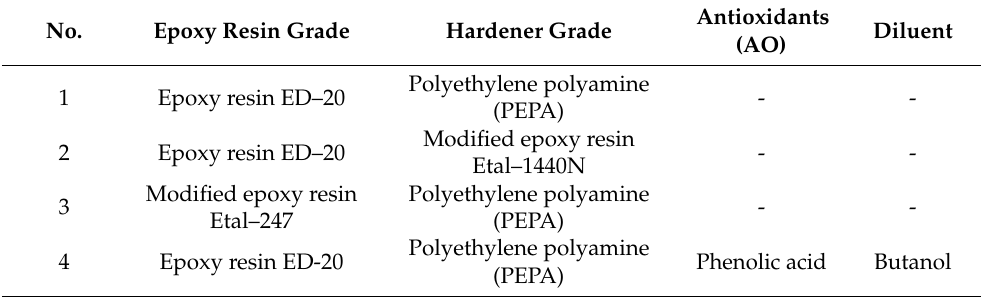
Table 2. Compositions of epoxy coatings exhibited on coal tar (CT)